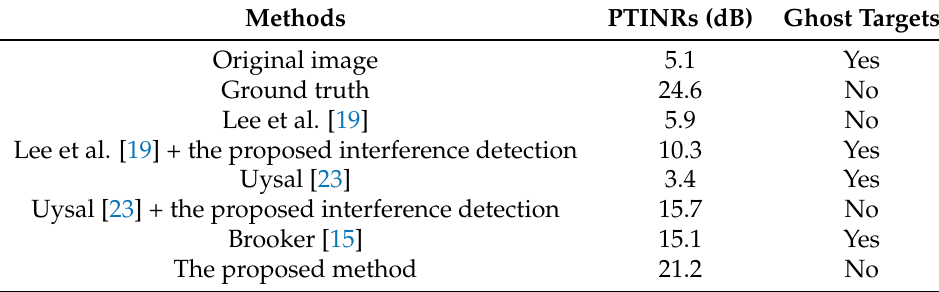
Table 4. Comparisons using measured real radar